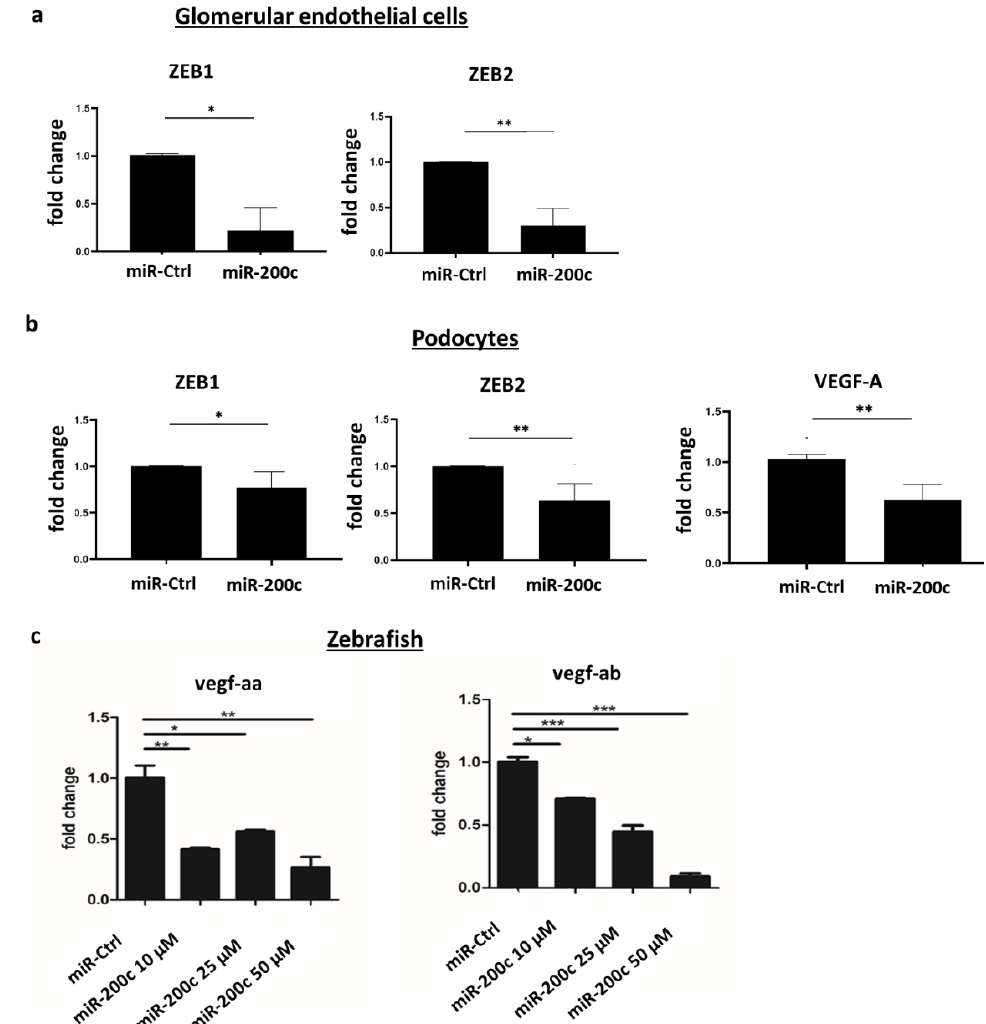
Figure 4. miR-200c overexpression alters the expression of ZEB1/2 and VEGF-A. ( a , b ) Cultured human glomerular endothelial cells and podocytes were transfected with an miR-control (miR-Ctrl) or miR-200c mimic (miR-200c), and qPCR was performed. ( a ) miR-200c-induced downregulation of ZEB1/2 in glomerular endothelial cells. ( b ) miR-200c-induced downregulation of ZEB1/2 and VEGF-A in podocytes. * p < 0.05, * p < 0.01, n = 4 independent experiments. ( c ) qPCR showing vegf-aa and vegf-ab mRNA expression after injection of miR-Ctrl or different concentrations of miR-200c mimic in zebrafish. Injections were performed at one two four cell stage. qPCR was performed 120 hpf. * p < 0.05, ** p < 0.01, *** p < 0.001. A pool of 20 zebrafish was used for RNA isolation in each group.